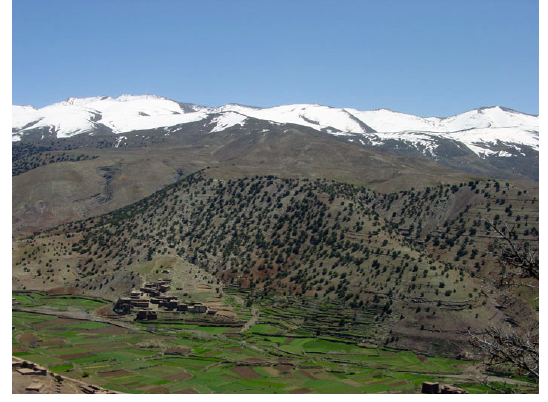
Fig. 7 . Overview of the diversified landscape found in the Aït Bouguemmez valley (photography by Didier